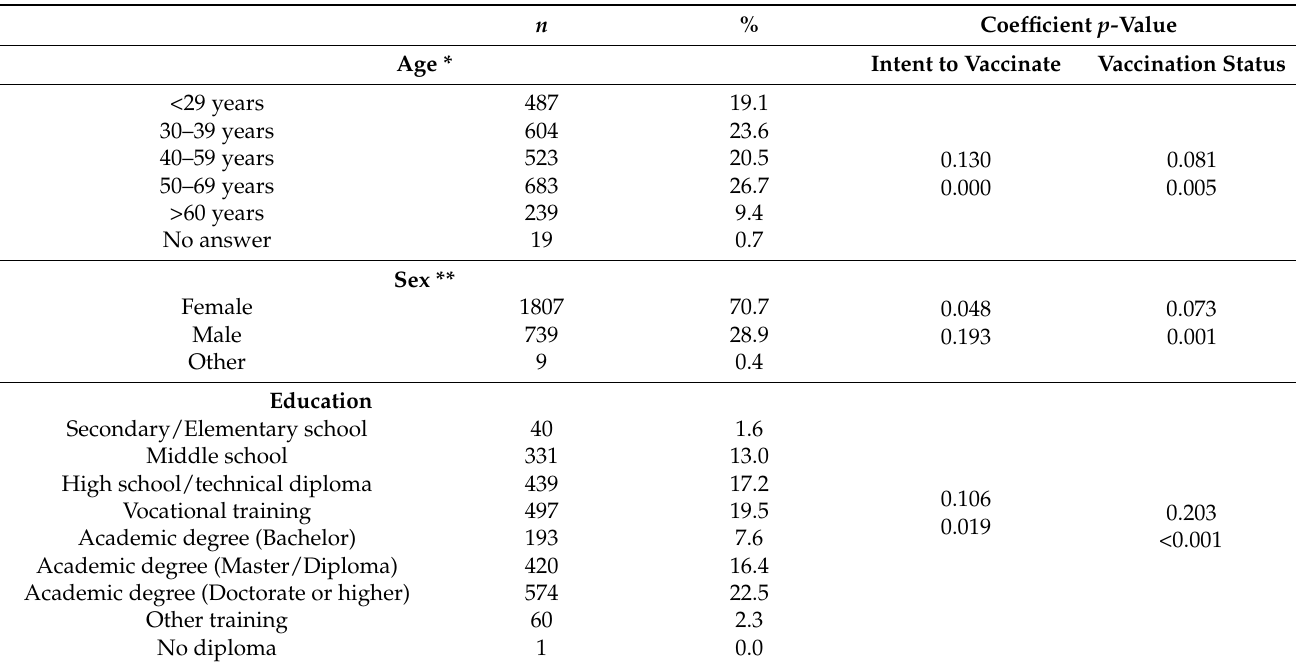
Table 1. Socio-demographic and occupational characteristics of